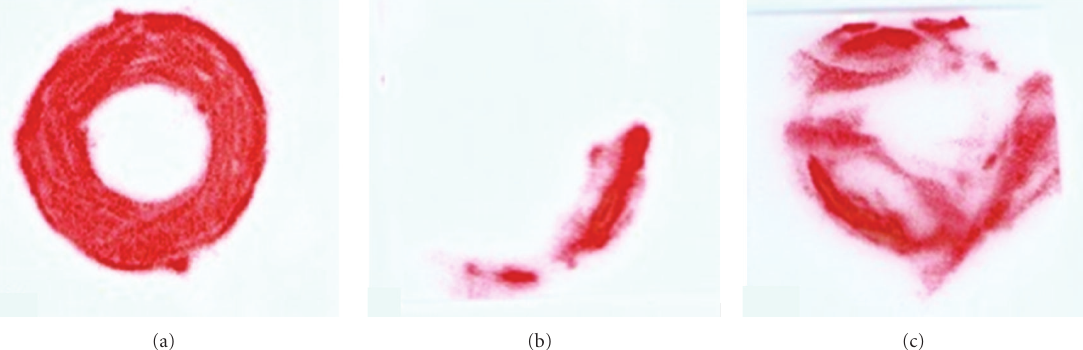
Figure 4: Scanned raw images of PRESSUREX film after contact at the allograft-host junction site made using the computer-assisted navigation technique. Of the 22 samples, contact area is seen in red for control (ideal) at 0.76sq.in. (a), minimal contact at 0.12 sq.in. (b), and maximal contact at 0.69 sq.in. (c).